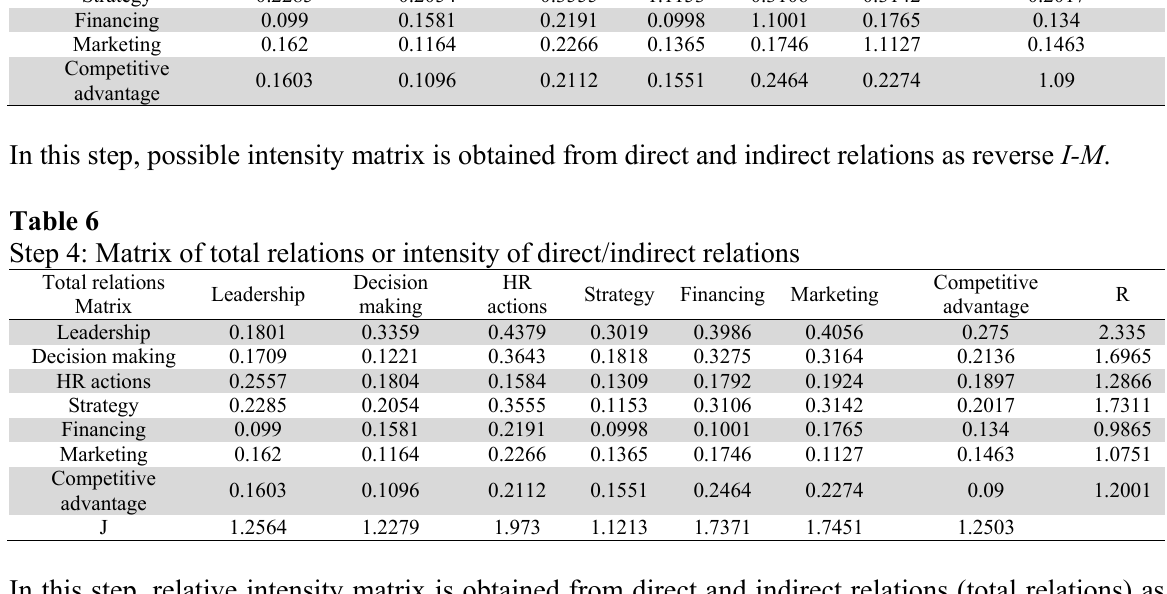
Step 3: Possible Intensity Matrix (Reverse) Reverse Matrix Leadership Leadership